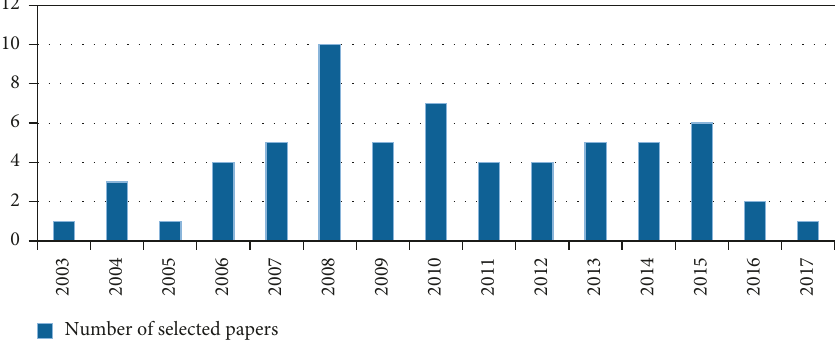
Figure 4: Selected papers by